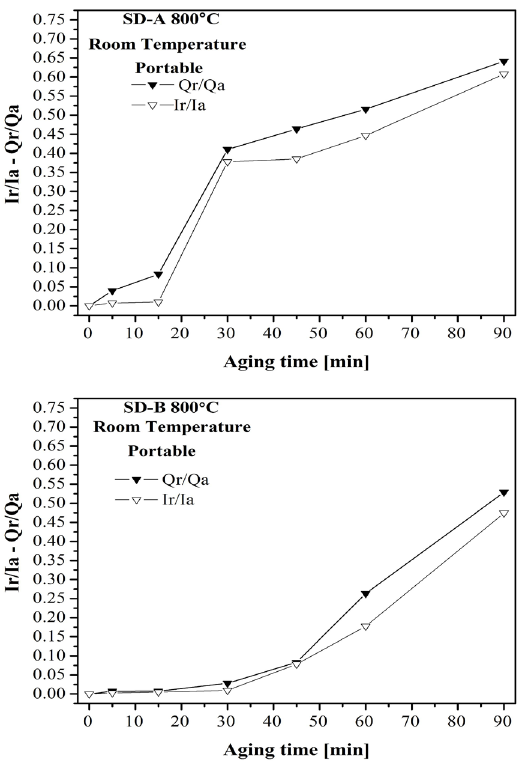
Figure 6. Qr/Qa ratios and deleterious phases precipitated percentage against aging time in SD-A samples aged at 800ºC till (a) 15 minutes and (b) 90